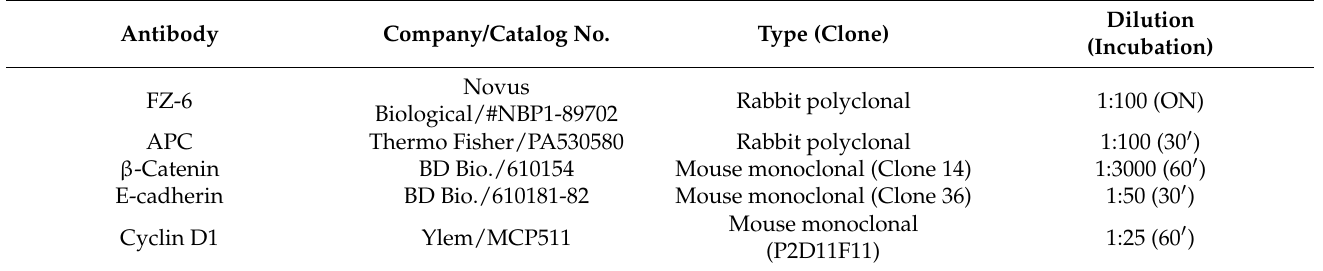
Table 1. List of